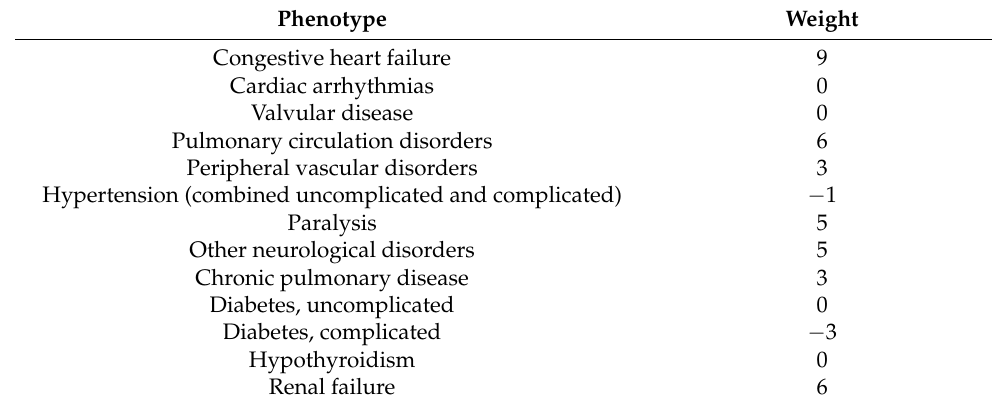
Table 1. Phenotypes of the Elixhauser Comorbidity Index and Respective Weights for